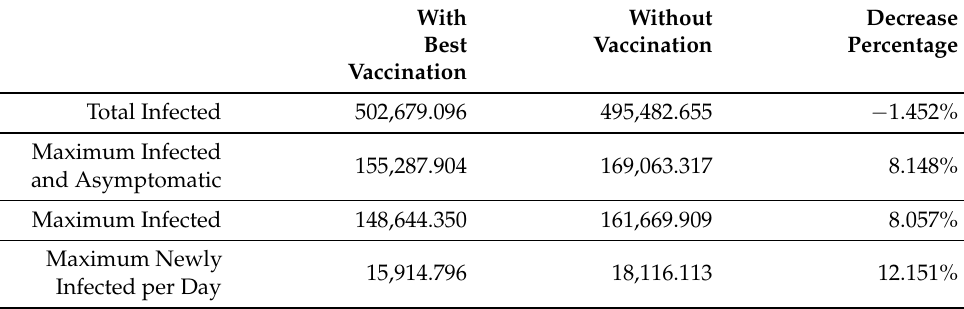
Table 10. Comparison table of infections with and without vaccination.